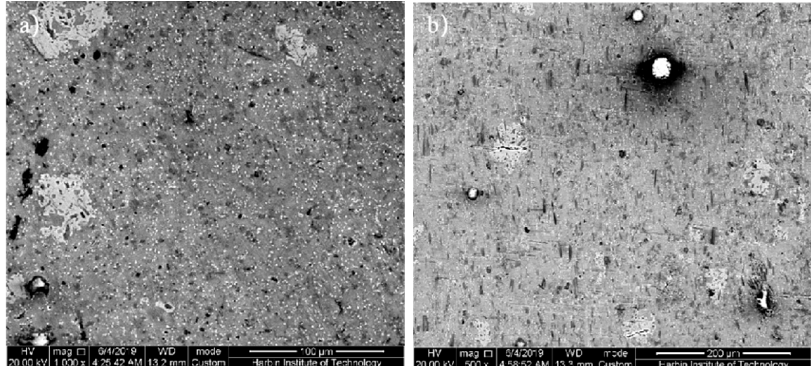
Figure 6. The SEM photograph of the microstructure of the extruded composite: ( a ) Transverse sec- tion; ( b ) Axial